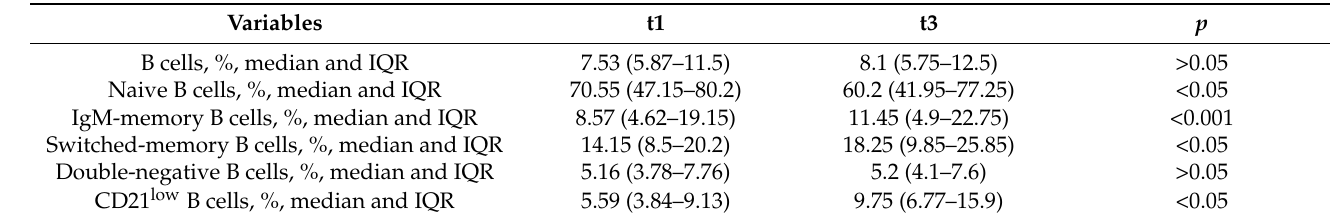
Table 3. B-cell subset distribution at t1 and t3 in 28 systemic sclerosis (SSc)